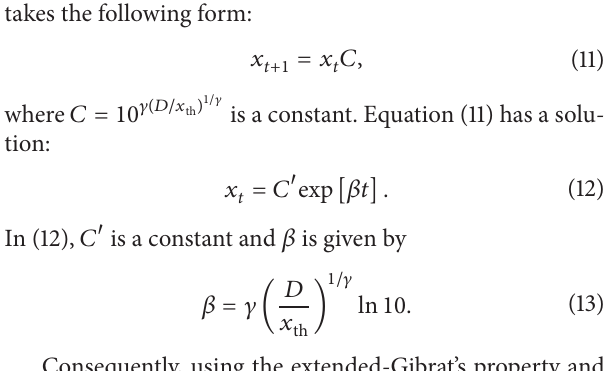
Figure 2: Conditional PDFs 𝑞(𝑟 | 𝑥 𝑇 ) times 𝑥 𝑇1/𝛾 with 𝛾 = 3.3 in Figure